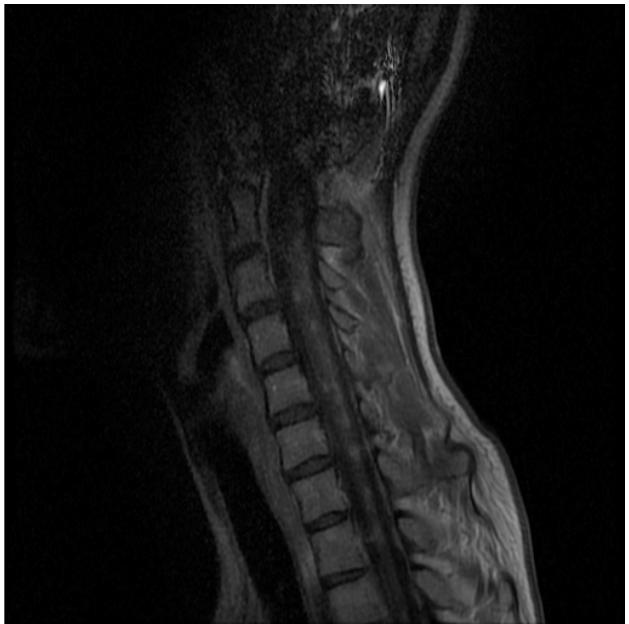
Figure 2. Cervica;-thoracic spine magnetic resonance imaging (MRI) of a patient with CLIPPERS (coronar post-contrast T1-weighted images). MRI shows in the spinal cord (along the entire length) uncountable small pinpoint and speckled foci, which underwent post-contrast enhance- ment.